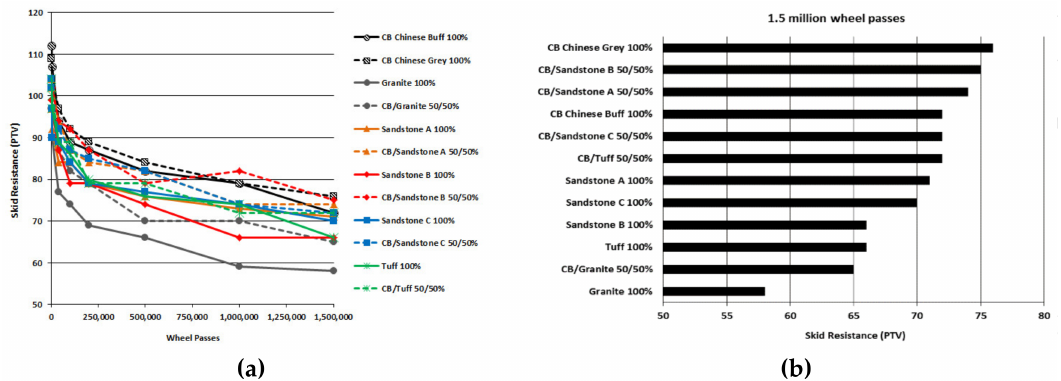
Figure 3. ( a ) Skid resistance development up to 1.5 million wheel-passes; ( b ) skid resistance ranking after 1.5 million wheel-passes (Aetec data).